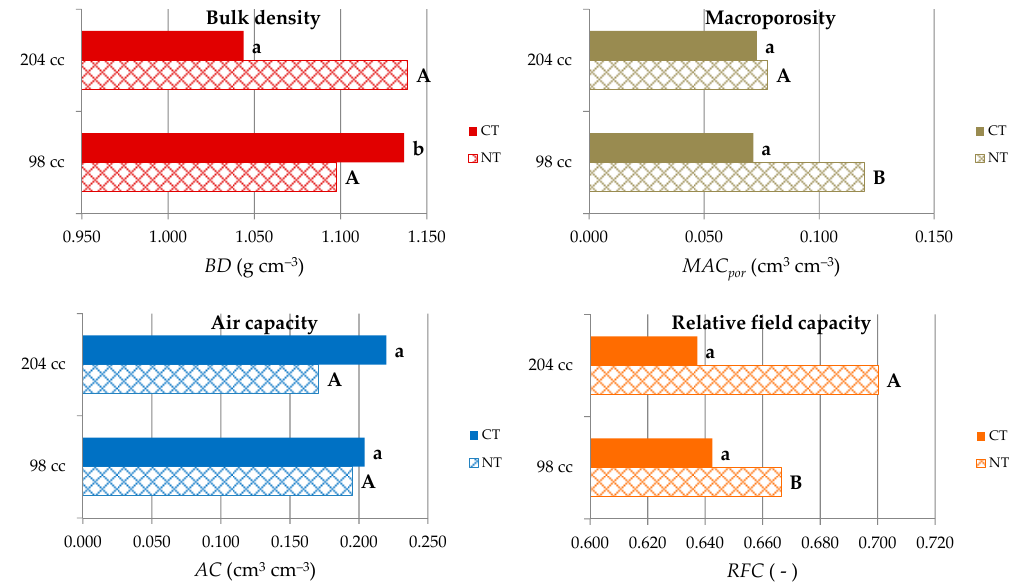
Figure 7. Soil physical quality indicators obtained using small (98 cc) and large (204 cc) soil cores under no-tillage (NT) and conventional tillage (CT) at Foggia in 2020. For a given soil management, mean values followed by the same letter (lowercase or capital letter, depending on soil use) were not statistically different, according to a two-tailed t-test ( P = 0.05).